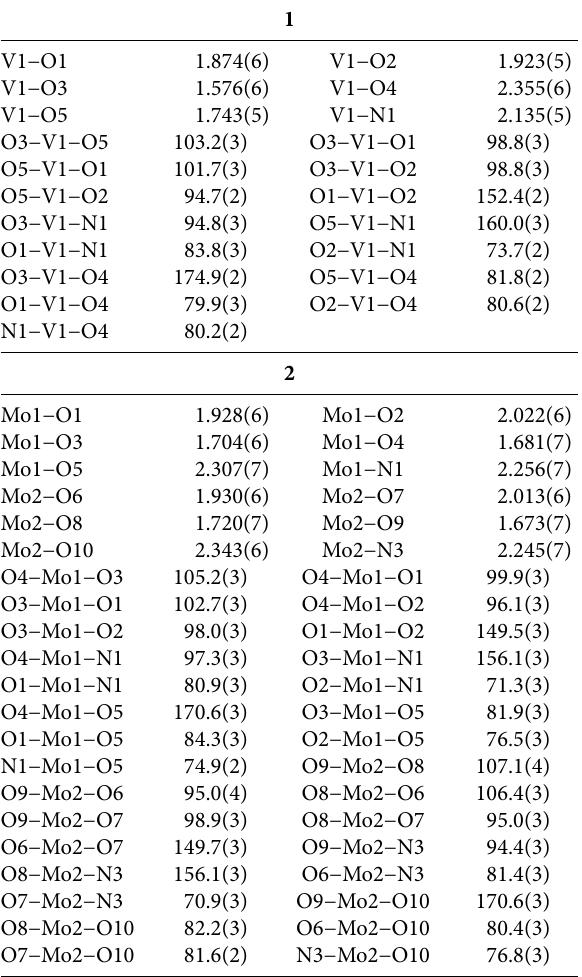
Table 3. Geometric parameters of hydrogen bonds for the